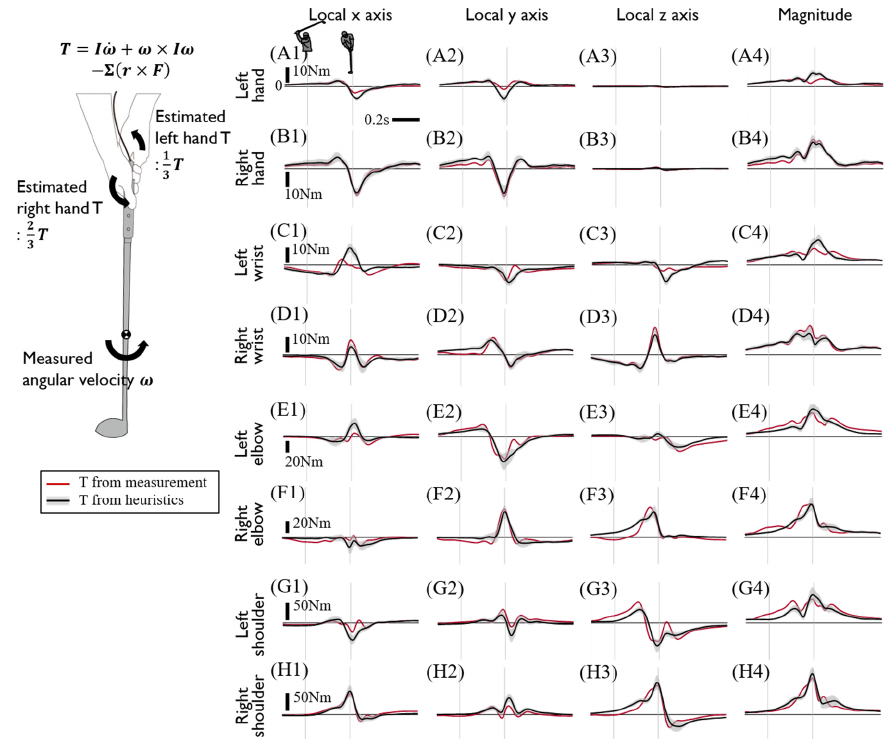
Figure 9. Calculated joint torques of the upper limbs using measured internal grip force and torque or estimated hand-grip joint force and torque. Each row shows the joint torques of the left hand-grip joint ( A 1– A 4), right hand-grip joint ( B 1– B 4), left wrist ( C 1– C 4), right wrist ( D 1– D 4), left elbow ( E 1– E 4), right elbow ( F 1– F 4), left shoulder ( G 1– G 4), and right shoulder ( H 1– H 4), respectively. Each column shows the x, y, and, z values and magnitude of joint torque at the local coordinate of the proximal segment, except for hand-grip joint. The hand-grip joint torque was analyzed using the club’s local coordinates. The black line with gray shading shows the joint torque calculated from the estimated hand-grip joint force and torque, and the red line shows the joint torque calculated from the measured internal grip force and torque. The torque acts on the distal segment of each joint and are the averages of driver swing data on all subjects. The two thin gray vertical lines indicate the backswing top and impact. The left picture briefly shows how to estimate the hand-grip joint torque.